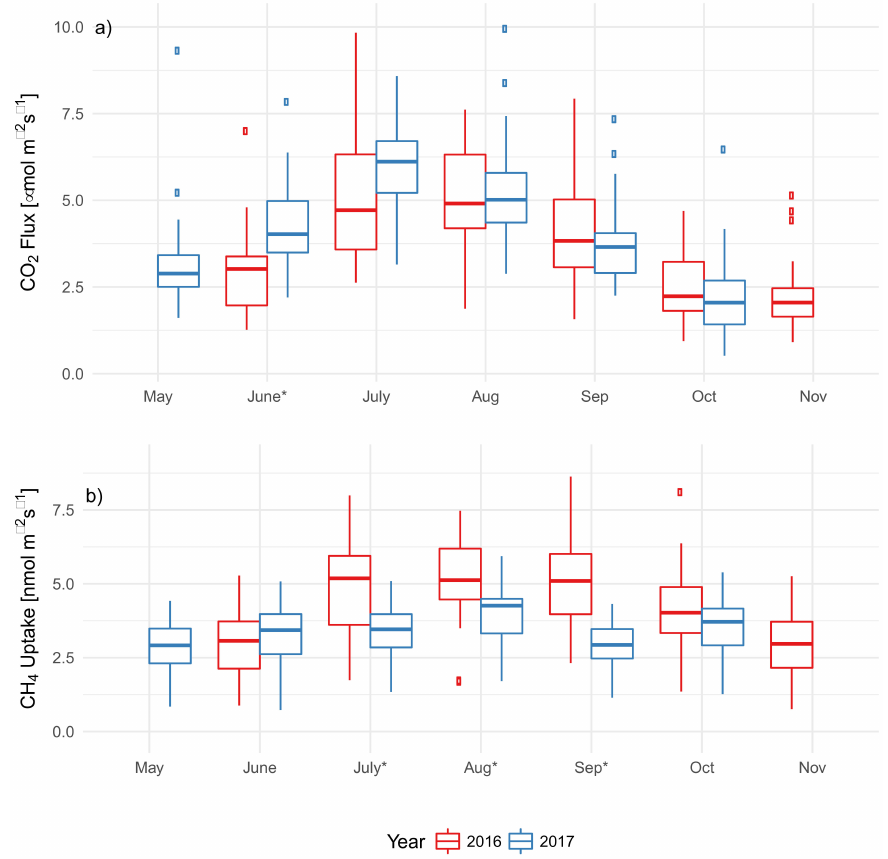
Figure 5. Seasonal patterns in CO 2 flux and CH 4 uptake: ( a ) monthly soil CO 2 flux and ( b ) monthly soil CH 4 uptake aggregated across all replicates both followed a clear seasonal pattern, with the highest efflux in mid-summer. For CO 2 flux, the measurements collected in 2016 and 2017 were significantly different only during June and July (paired t -test, p < 0.05) and the CH 4 uptakes in 2016 and 2017 were significantly different during July, August, and September (paired t -test, p <